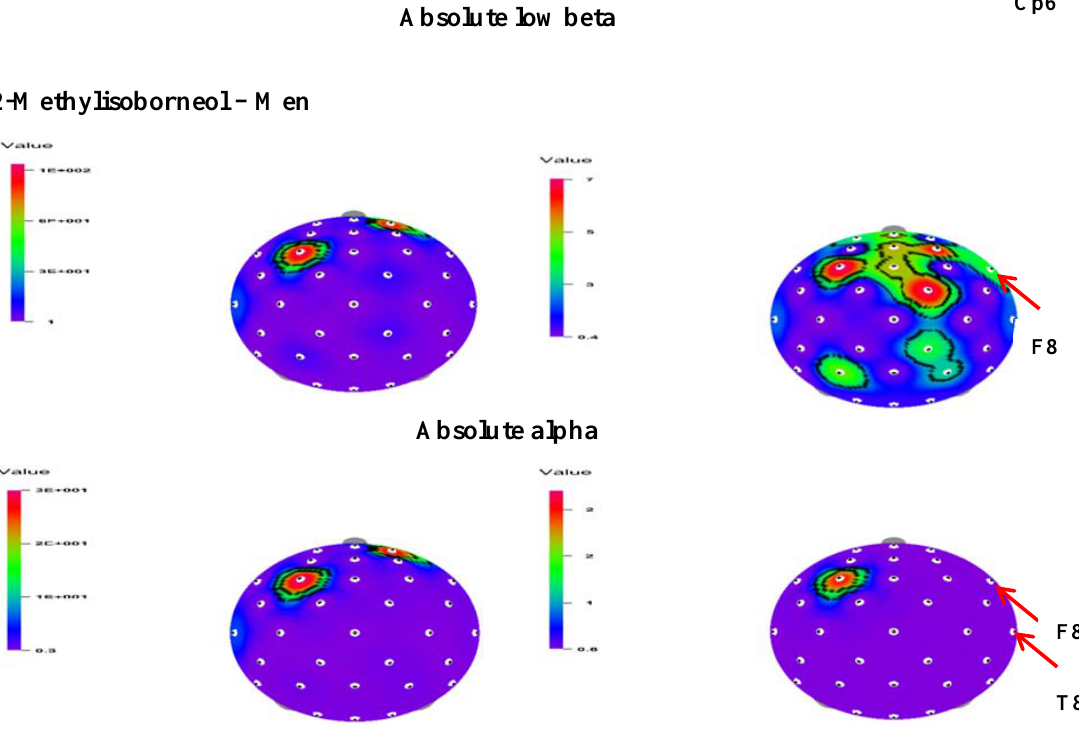
Figure 3. t-Mapping of EEG changes (absolute waves) before and during the inhalation of geosmin in women and 2-methylisoborneol in women. Arrows show the significant changes in the regions during the inhalation of geosmin and 2 ‐ methylisoborneol.